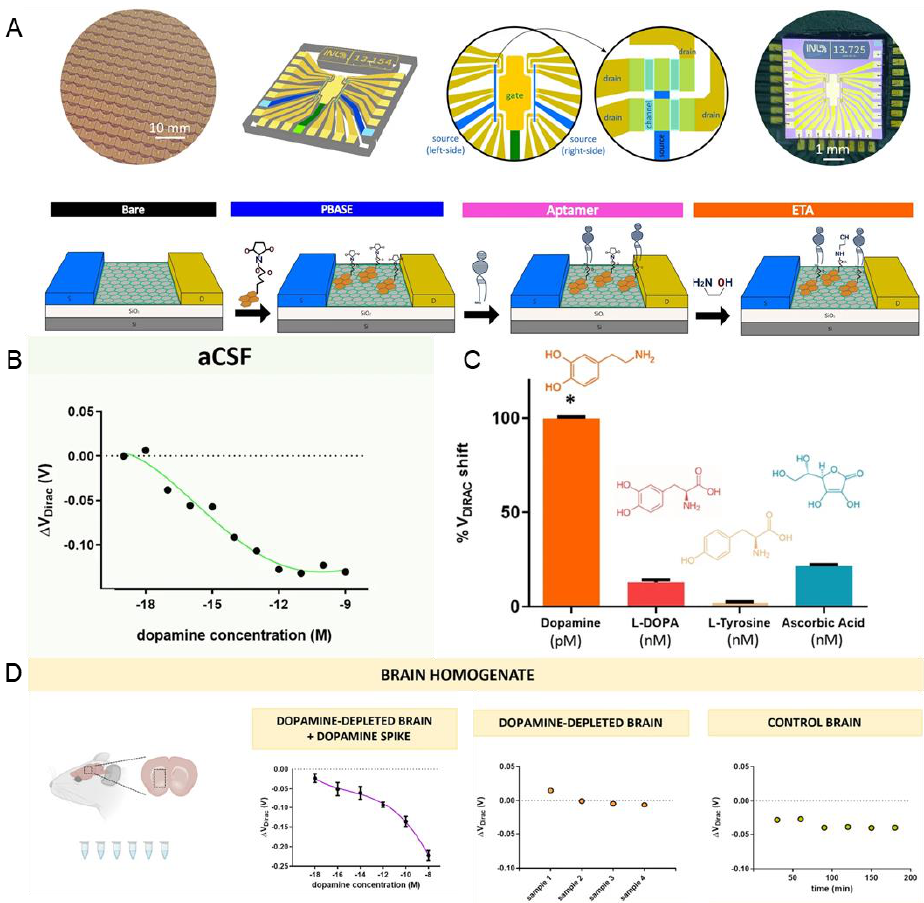
Figure 4. Graphene-based aptamer sensors for DA detection. ( A ) Schematic illustration of the fabrication process of graphene-based aptamer sensors. ( B ) Calibration plot indicating the linear range and LOD of DA. ( C ) Selectivity of the fabricated aptamer sensor. ( D ) Schematic illustration of the in vivo DA detection and the dot plots showing the in vivo detection performance. With permission from [65]. Copyright 2022, BMC. PBASE, pyrene-derived crosslinker; ETA, ethanolamine; aCSF, artificial cerebrospinal fluid. * p < 0.05.